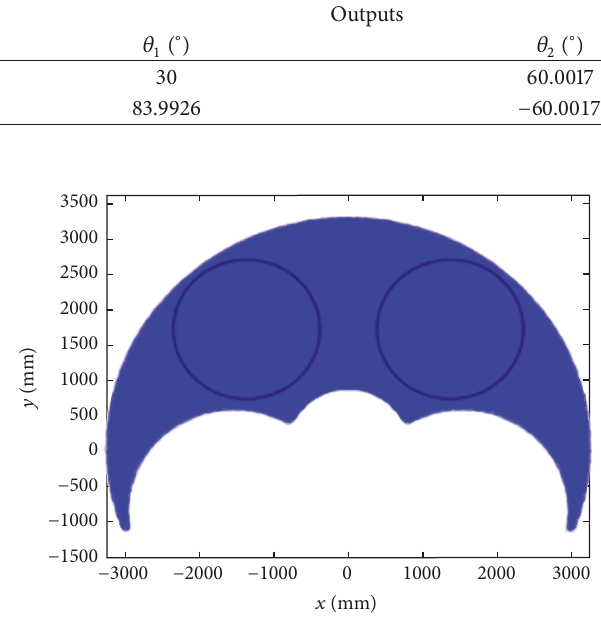
Figure 6: Different configurations for forward position.